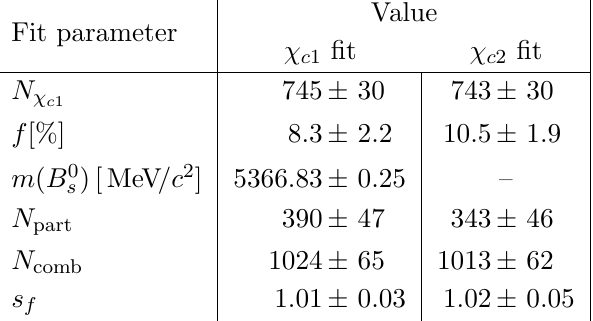
+ K + K (cid:0) and (cid:31) c 2 K (cid:0) (cid:12)ts to the invariant-mass distributions. A c 1 K